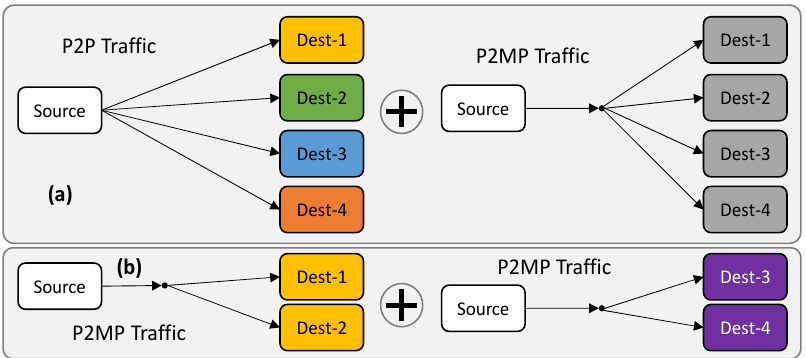
Figure 4. Example of traffic configurations supported by OCS. P2P + P2MP traffic (a) and P2MP traffic (b) (updated from [16]).